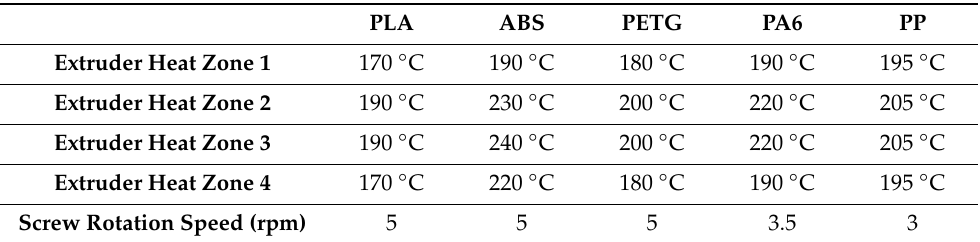
Table 1. Extrusion specifications used for the filament fabrication on the three-dimensional (3D) Evo Composer 450 filament extruder.